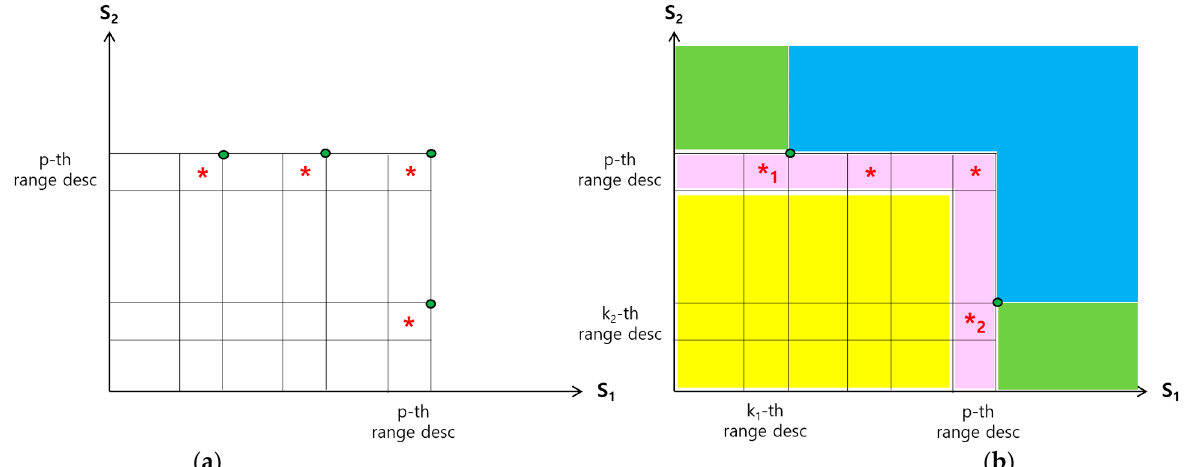
Figure 9. Skyline filtering using anchor points. ( a ) Join matches in one or more range pairs. In each of the range pairs marked with *, one or more join matches are found. The green dots are possible anchor points. ( b ) Skyline filtering using two anchor points. The green dots are the anchor points employed.